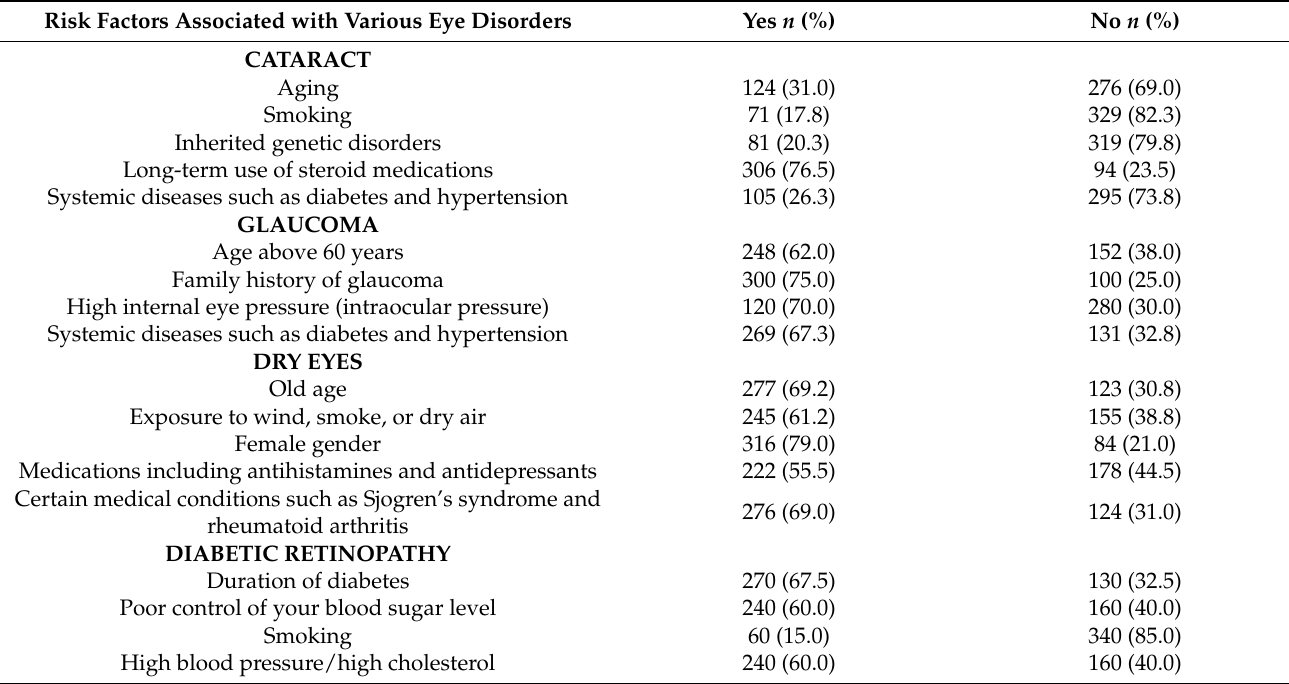
Figure 1. Participants’ awareness of eye disorders. Table 2. Awareness of different risk factors associated with various eye disorders.